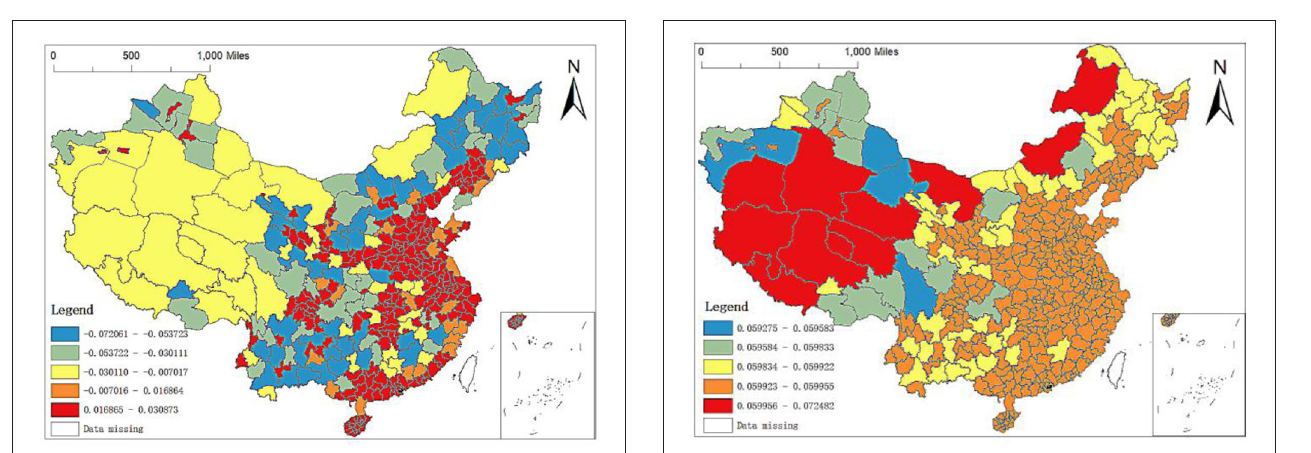
FIGURE 8 | Spatial distribution of regression coefficients of population density.